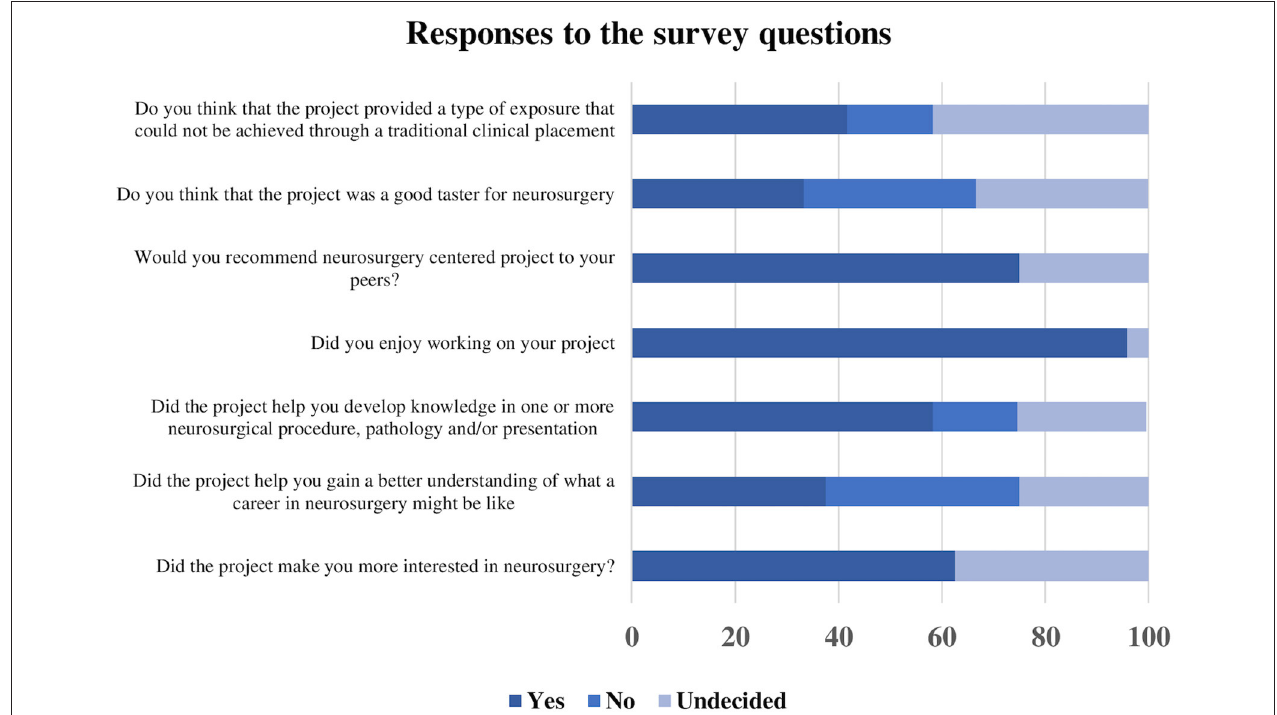
FIGURE 2 | Responses to the survey questions assessing the value of undergraduate